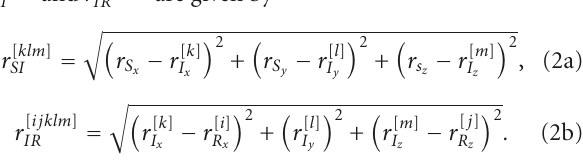
Figure 2: (a) Elevation and (b) floor plan of the corridor with the measurement